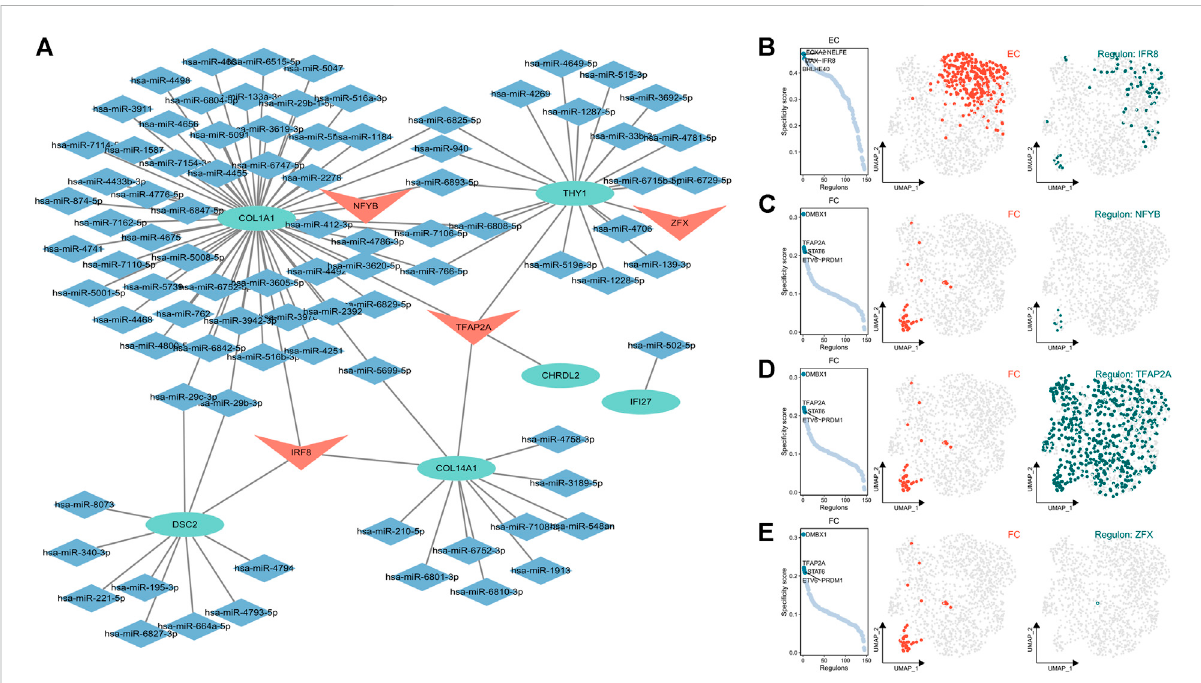
FIGURE 9 Establishment of TF-mRNA-miRNA regulatory network. (A) The TF-mRNA-miRNA regulatory network (TF, v-shaped frame; mRNA, oval shape; miRNA, rhombus); (B) Activity of TFs speci fi c to ECs (from left to right: TF rank based on the regulon score, UMAP plot of the regulon activity, TF IFR8regulonactivity); (C – E) ActivityofTFsspeci fi ctoFCs(fromlefttoright:TFrankbasedontheregulonscore,UMAPplotoftheregulonactivity,TF (C) NFY8, (TFAP2A), and (ZFX) regulon